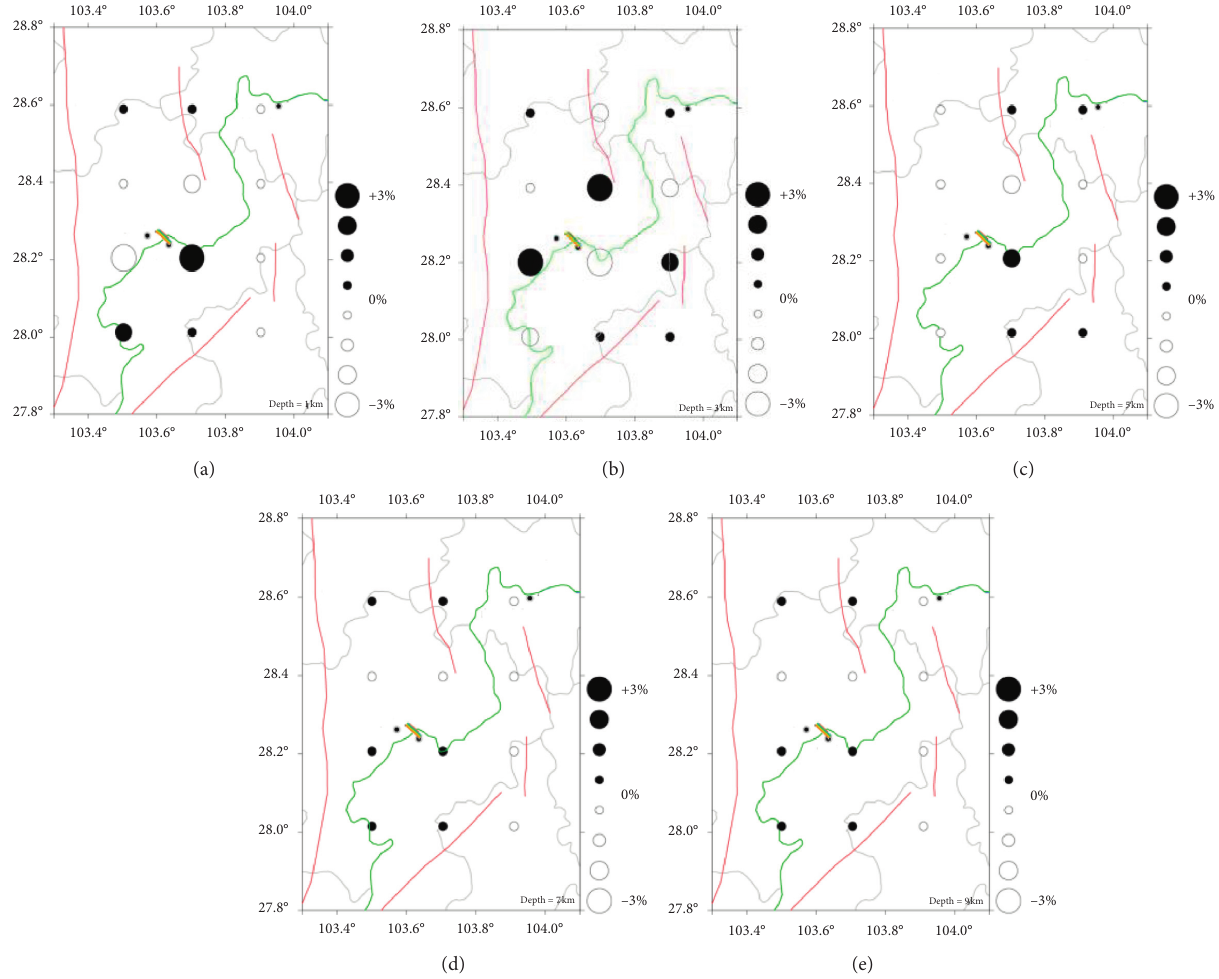
Figure 5: Resolution detection results of P -wave test plate at different depths: (a) 1km; (b) 3km; (c) 5km; (d) 7km; (e)